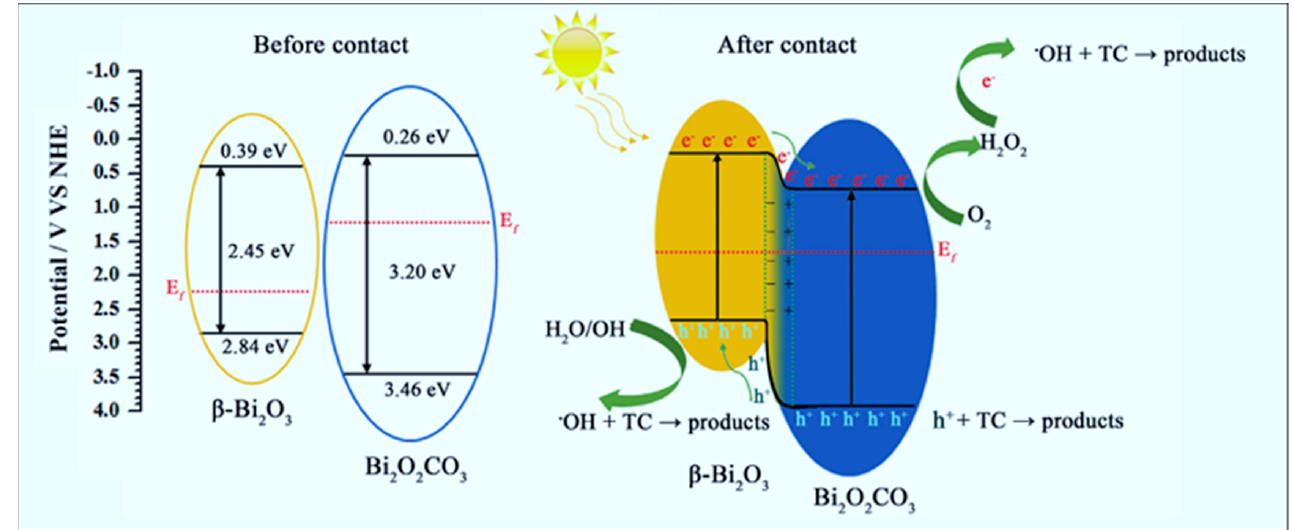
Figure 7. Schematic representation of the band structure of the β− Bi 2 O 3 /Bi 2 O 2 CO 3 heterojunction and the migration of photogenerated charges under simulated sunlight irradiation [106].